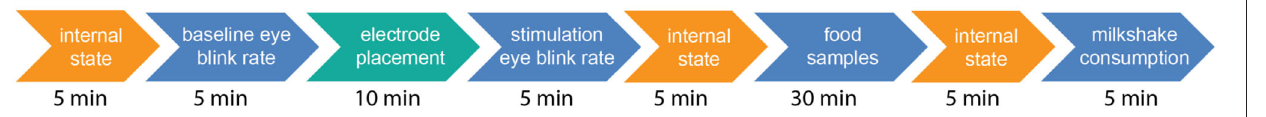
FIGURE 1 | Order of tasks in a test session and approximate timing in minutes. Upon arrival at the laboratory, participants rated their hunger, fullness and thirst (“internal state”). Then a baseline spontaneous eye blink rate (SEBR) was assessed, then the stimulation device was turned on and the intensity for sham or tVNS stimulation was adjusted. Next VNS stimulation perception was assessed. Then the rest of the tasks were performed concurrent with stimulation: another SEBR measurement, internal state ratings, rating of food samples, internal state ratings and last ad libitum milkshake consumption. This entire procedure was repeated on two testing days, one session using sham stimulation on the earlobe, and one session using tVNS stimulation on the cymba conchae (order of sessions counterbalanced over